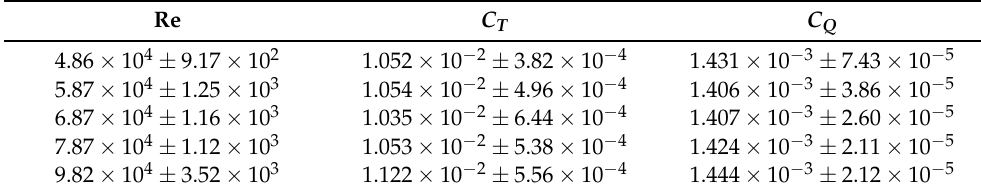
Table A1. Experimental